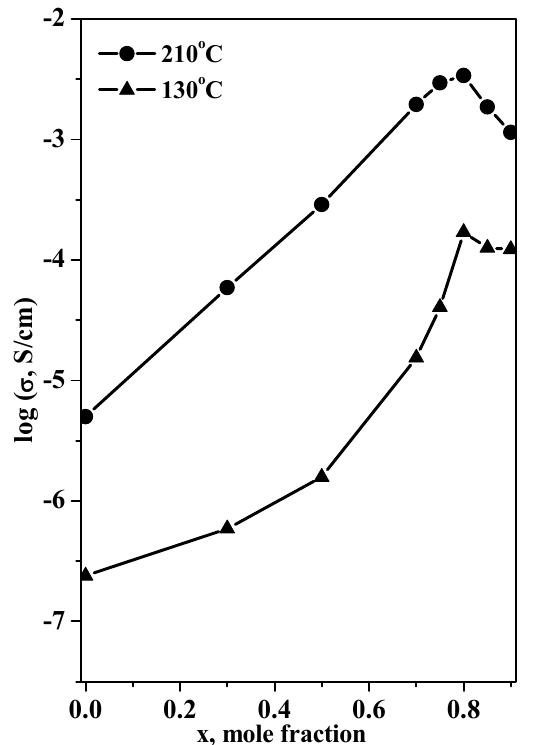
Figure 9. The isotherms of the conductivity of (1 – x)Et 4 NHSO 4 –xSiO 2 at different temperatures as a function of the mole fraction of SiO 2 .